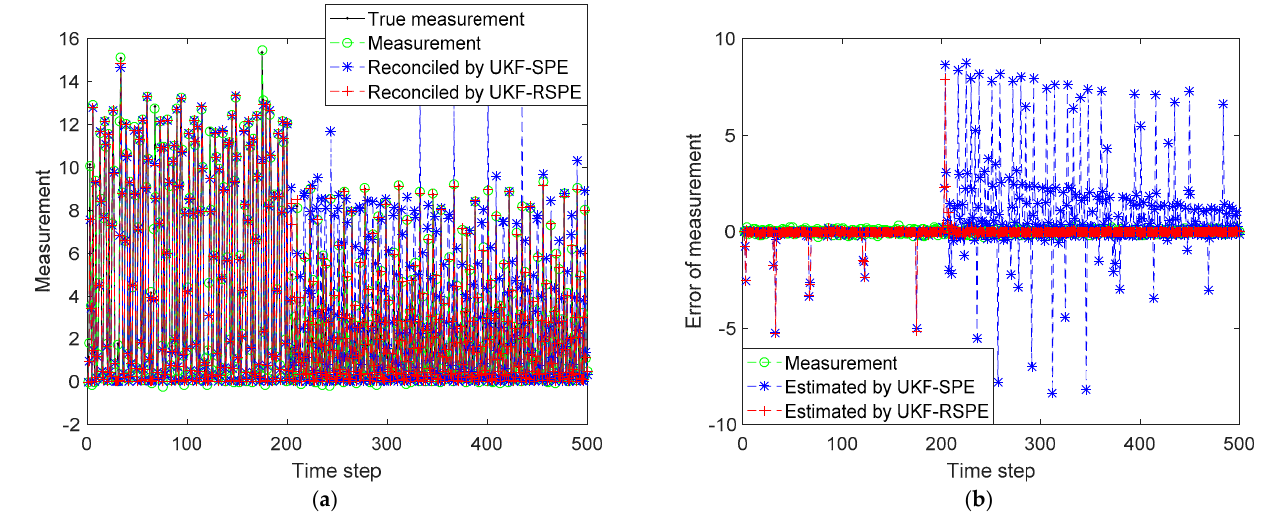
Figure 7. The comparison of the reconciled results of measurement in Case Study 1: ( a ) reconciled measurement; ( b ) measurement error. Table 1. Statistical information of estimated results in Case Study 1.